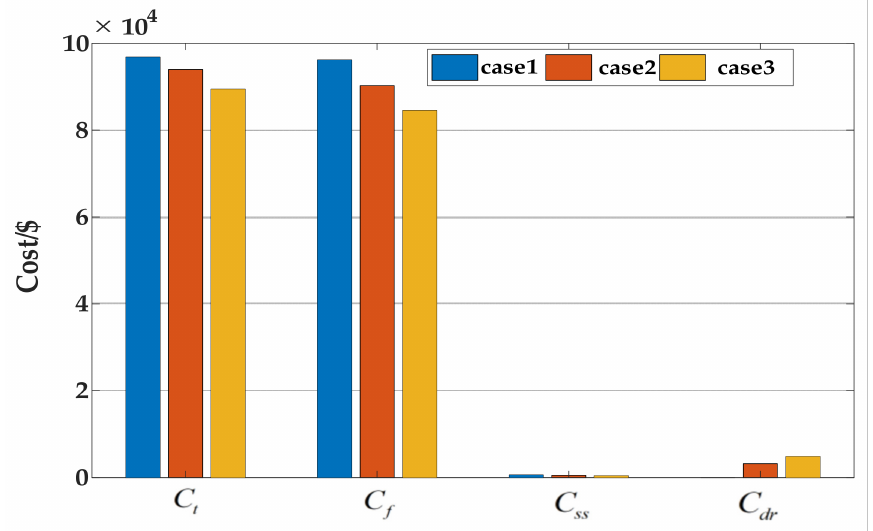
Figure 14. Comparison of the system operating costs in three cases. As shown in Figure 11, the costs of unit operating and startup/shutdown on the source side of the system were reduced because of the participation of DR and wind